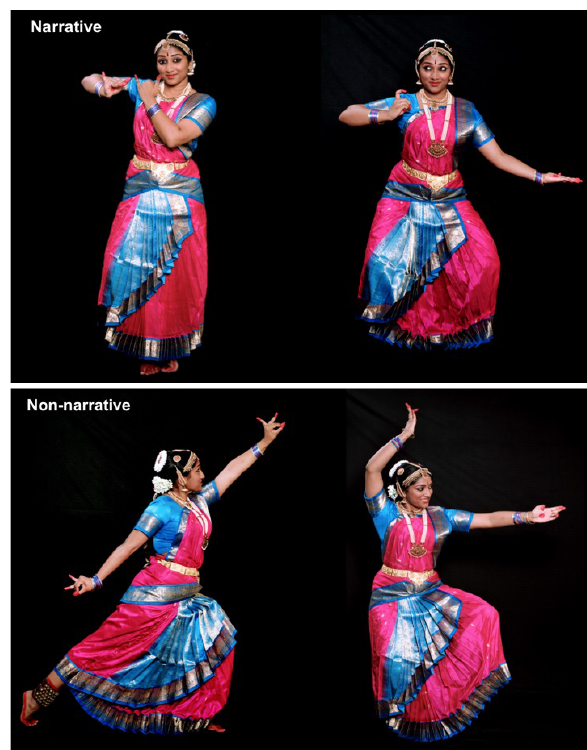
Figure 1. Stills from narrative ( nritya ; top) and non-narrative ( nritta ; bottom) video stimuli.